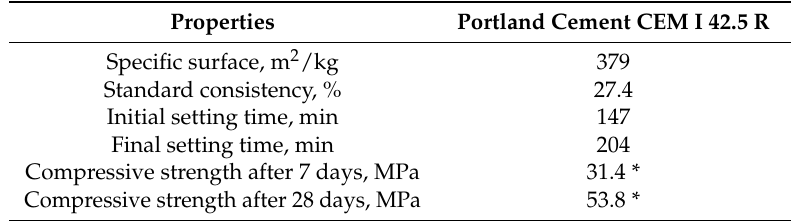
Table 2. Physical and mechanical properties of cement (data provided by producer).